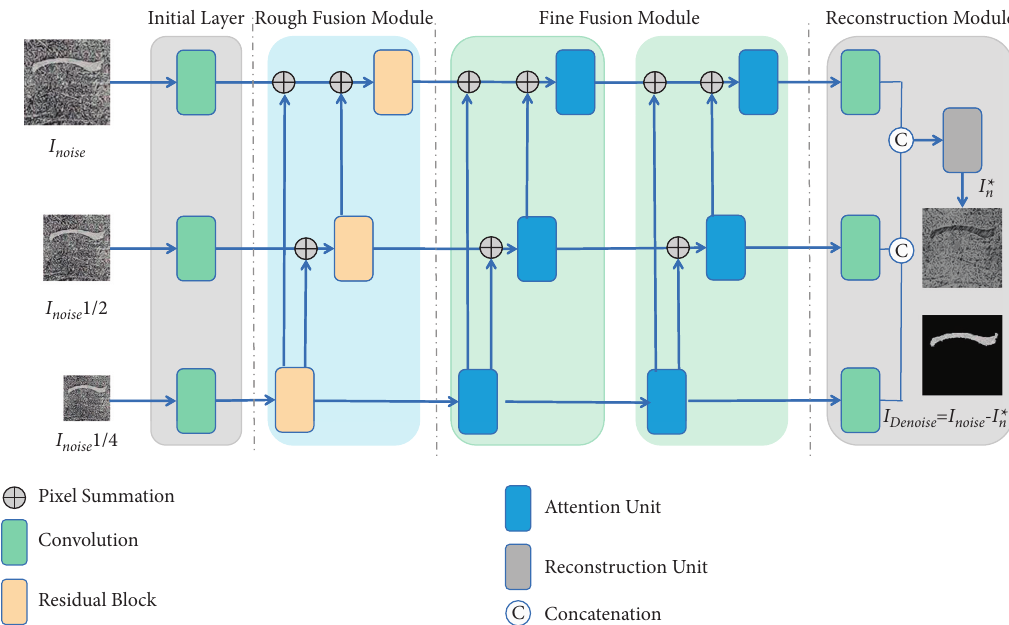
Figure 3: Image denoising network based on multiscale feature fusion.